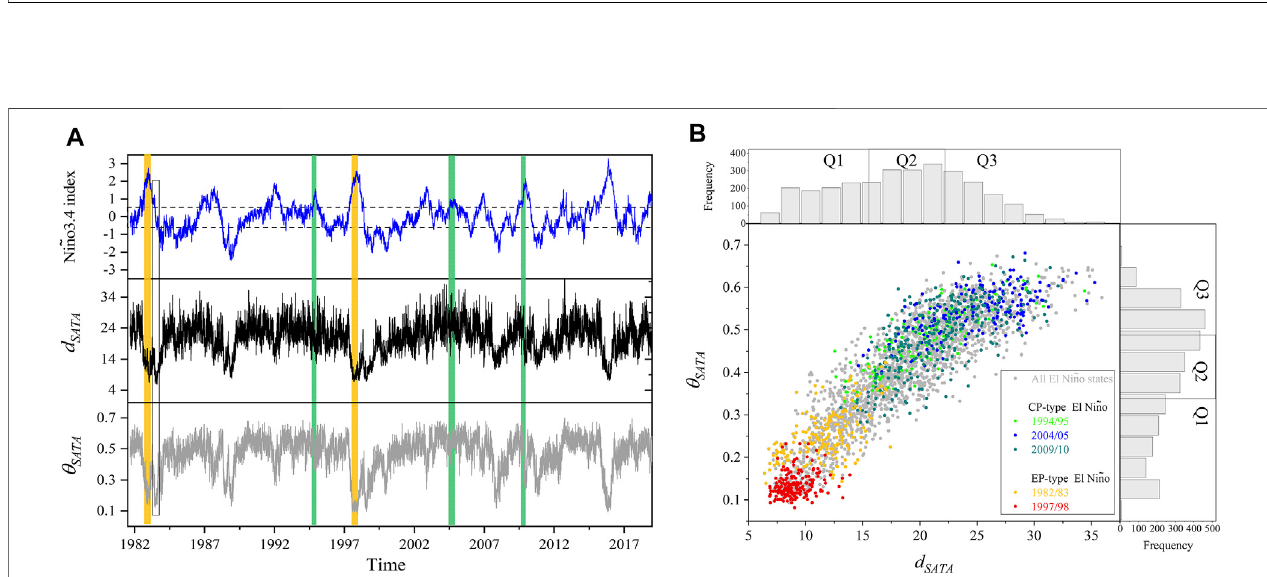
FIGURE 4 | Analyses of the dynamical system parameters during El Niño episodes. (A) Time series of Niño34 index, d SATA and θ SATA . The dash lines across the Niño3.4indexdenotetheupperandlowerthresholdof±0.5.Theyellowandgreenbarsindicatethetypical EPandCPElNiñoevents(EP:1982/83,1997/98;CP:1994/ 95, 2004/05, 2009/10). (B) Scatter plots of θ SATA versus d SATA during El Niño days. Days within the typical EP and CP El Niño events are, respectively, illustrated. The histogram of θ SATA is divided into the lowest 1/3 (Q1), the middle 1/3 (Q2), and the highest 1/3 (Q3) according to its quantiles, and so does d SATA .